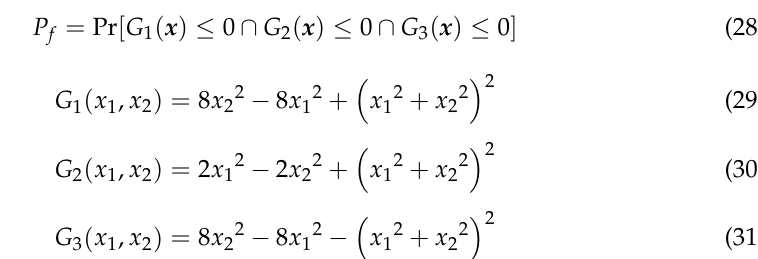
surface, and the sample quality is lower than that of the proposed method.